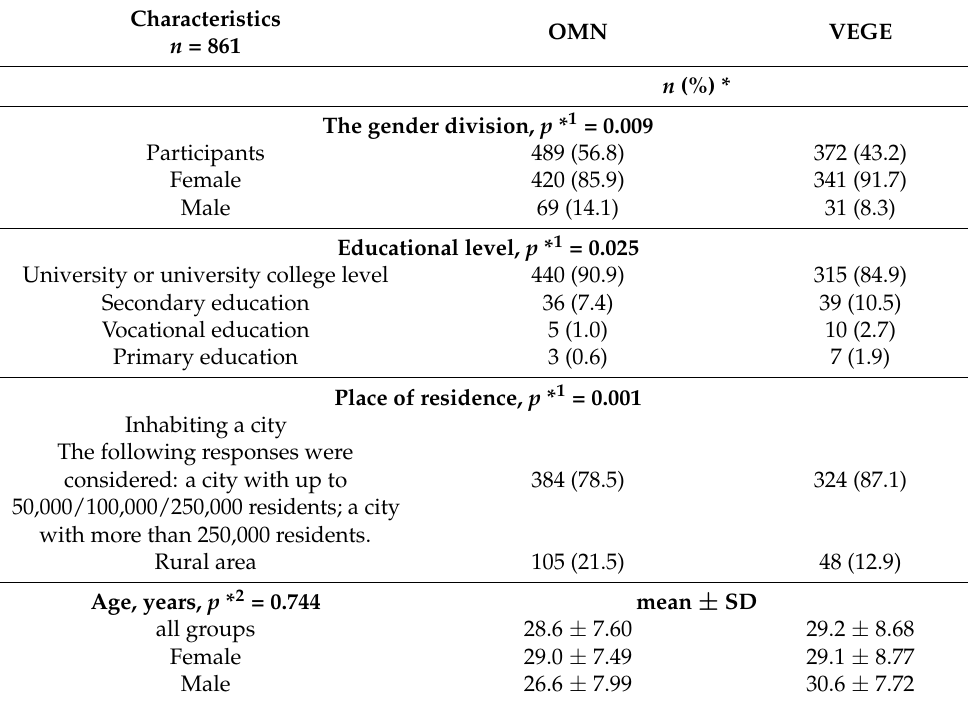
Table 1. Characteristics of the study groups.